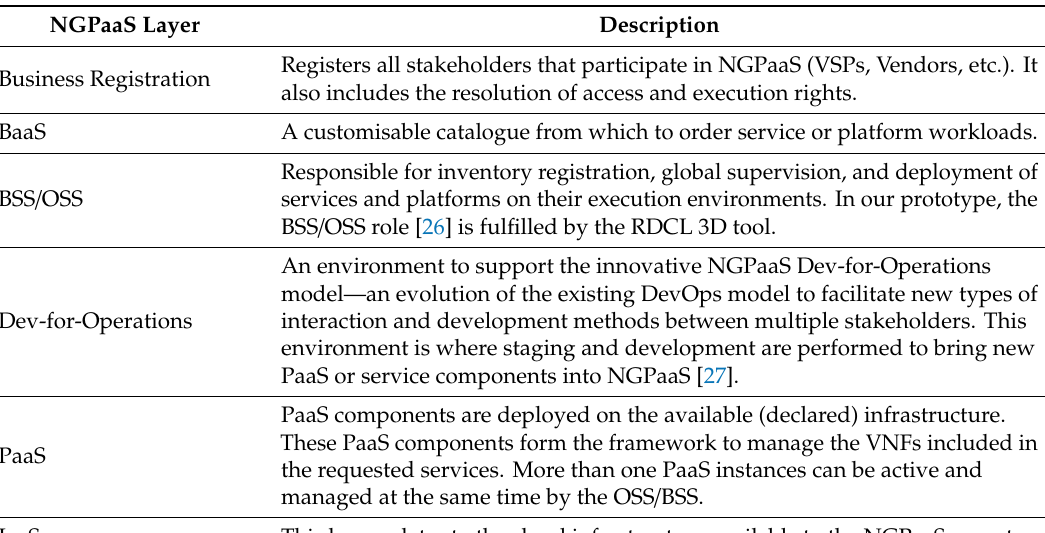
Table 1. Layers of the NGPaaS